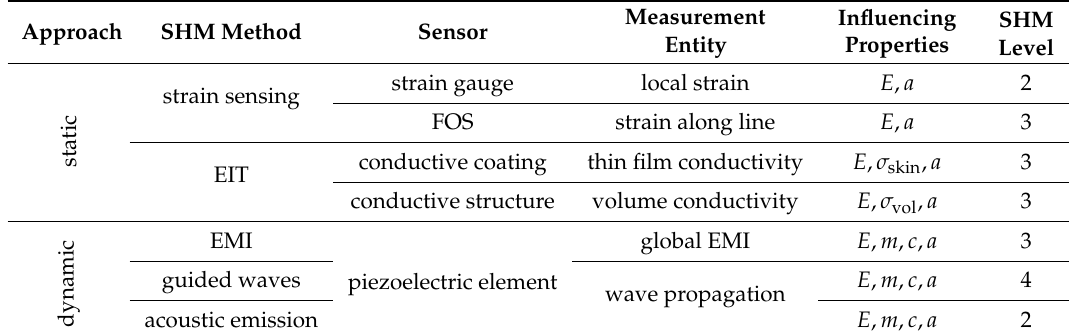
Table 3. Influence of structural properties in SHM